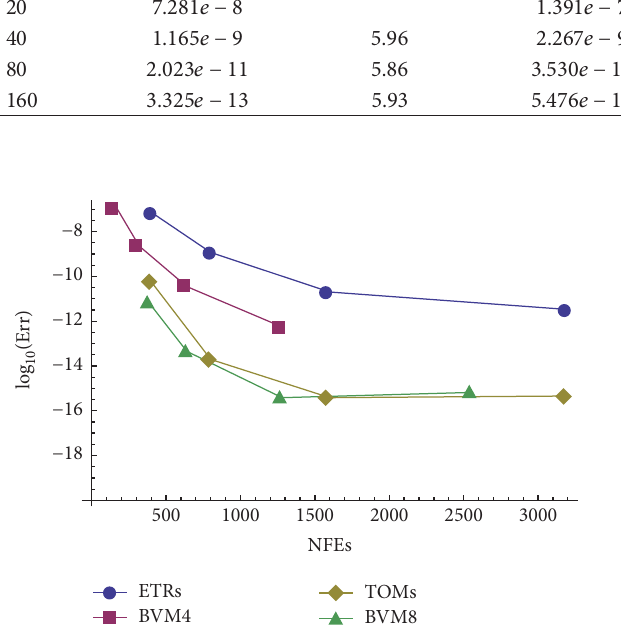
Figure 1: Efficiency curve for Example 1. Figure 2: Efficiency curve for Example